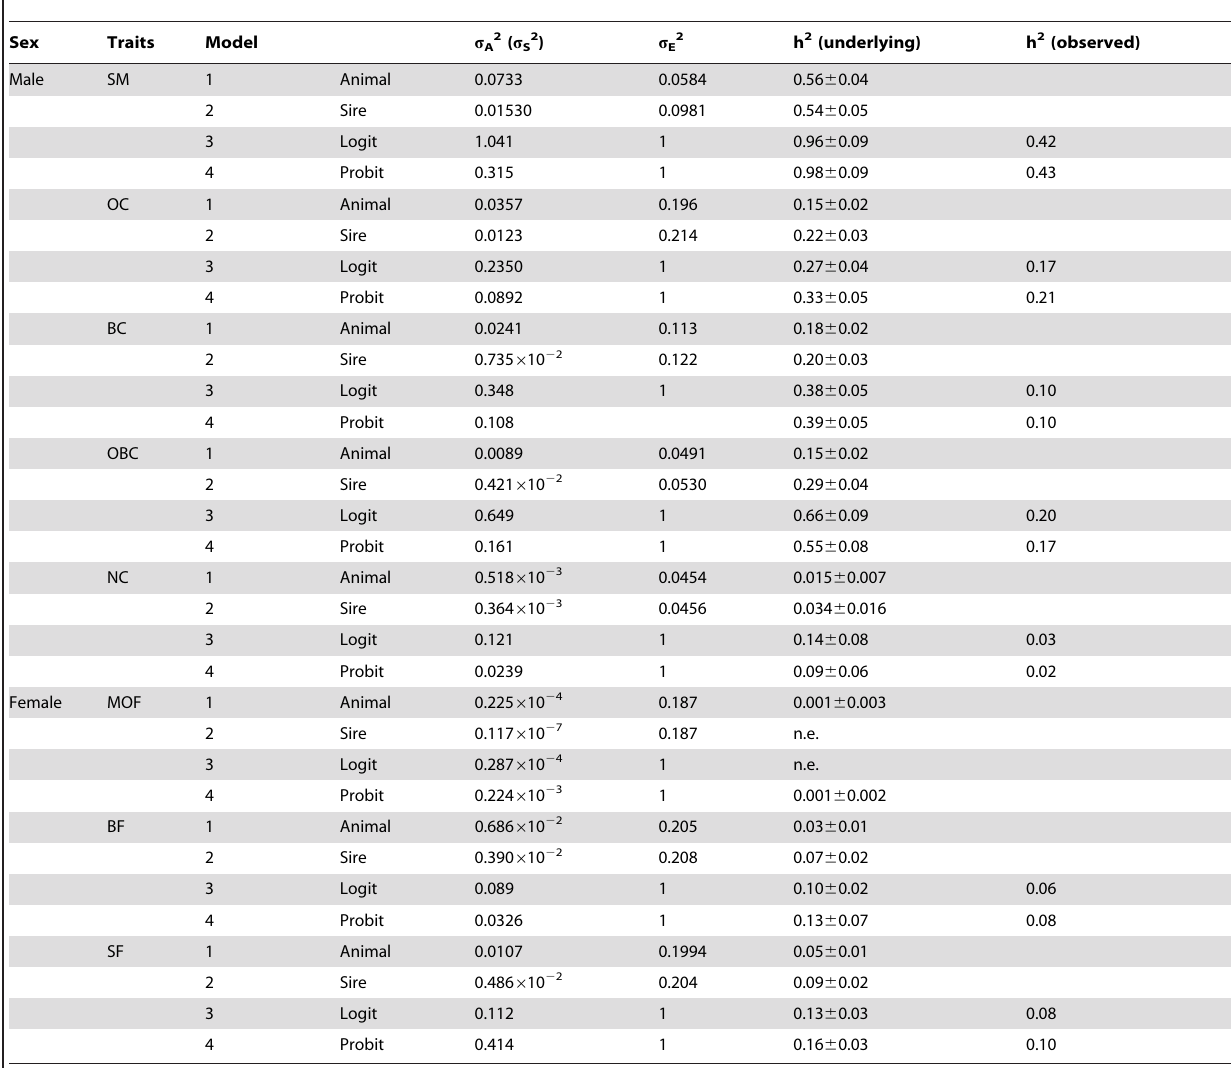
Table 3. Heritability ( 6 s.e.) for male morphotypes and female reproductive statuses estimated with four different statistical models.